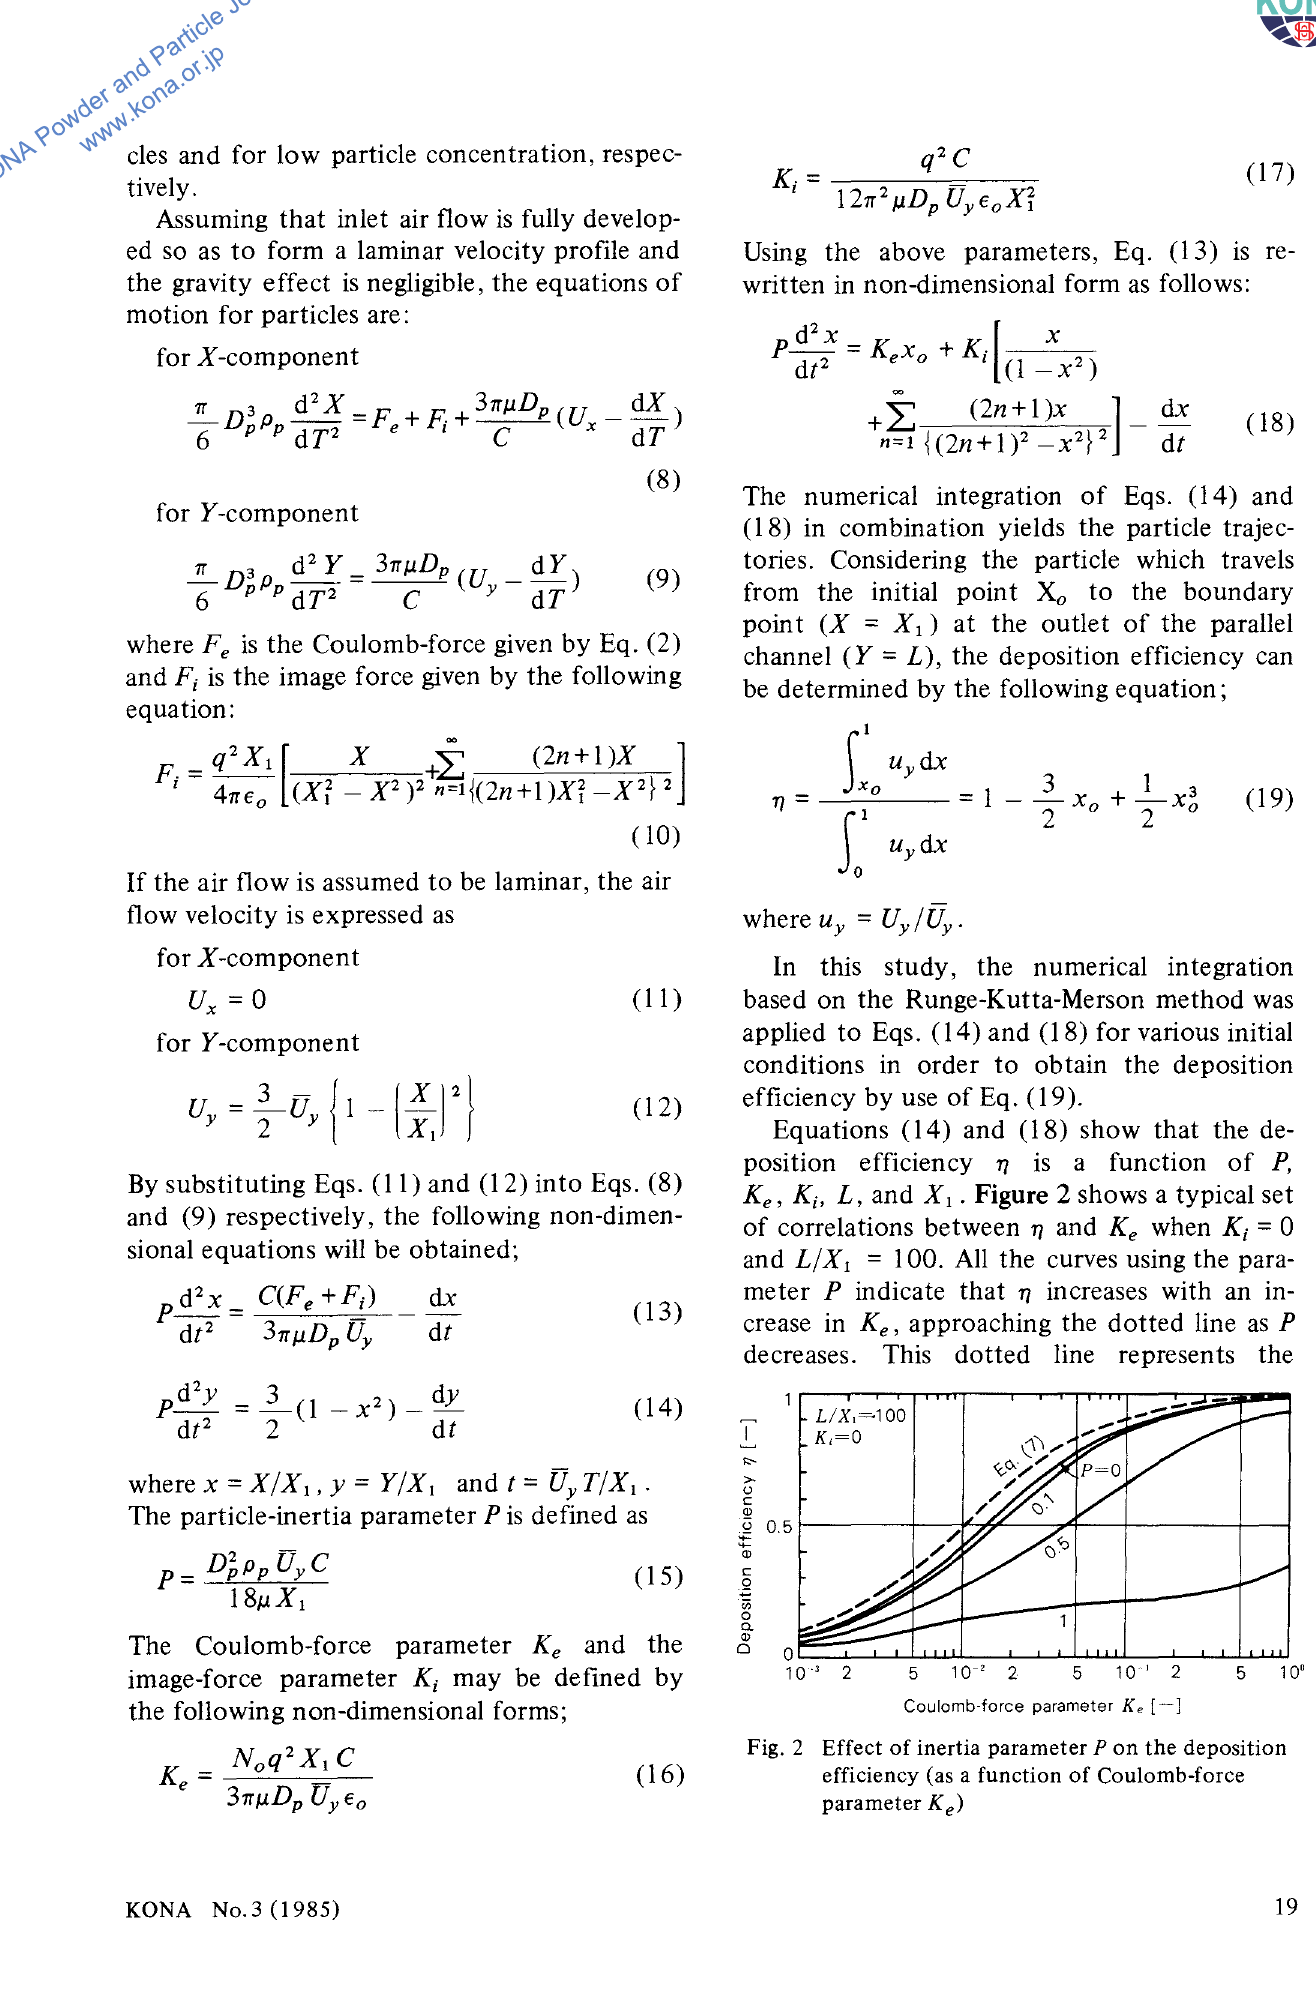
Fig. 2 Effect of inertia parameter P on the deposition efficiency (as a function of Coulomb-force parameter